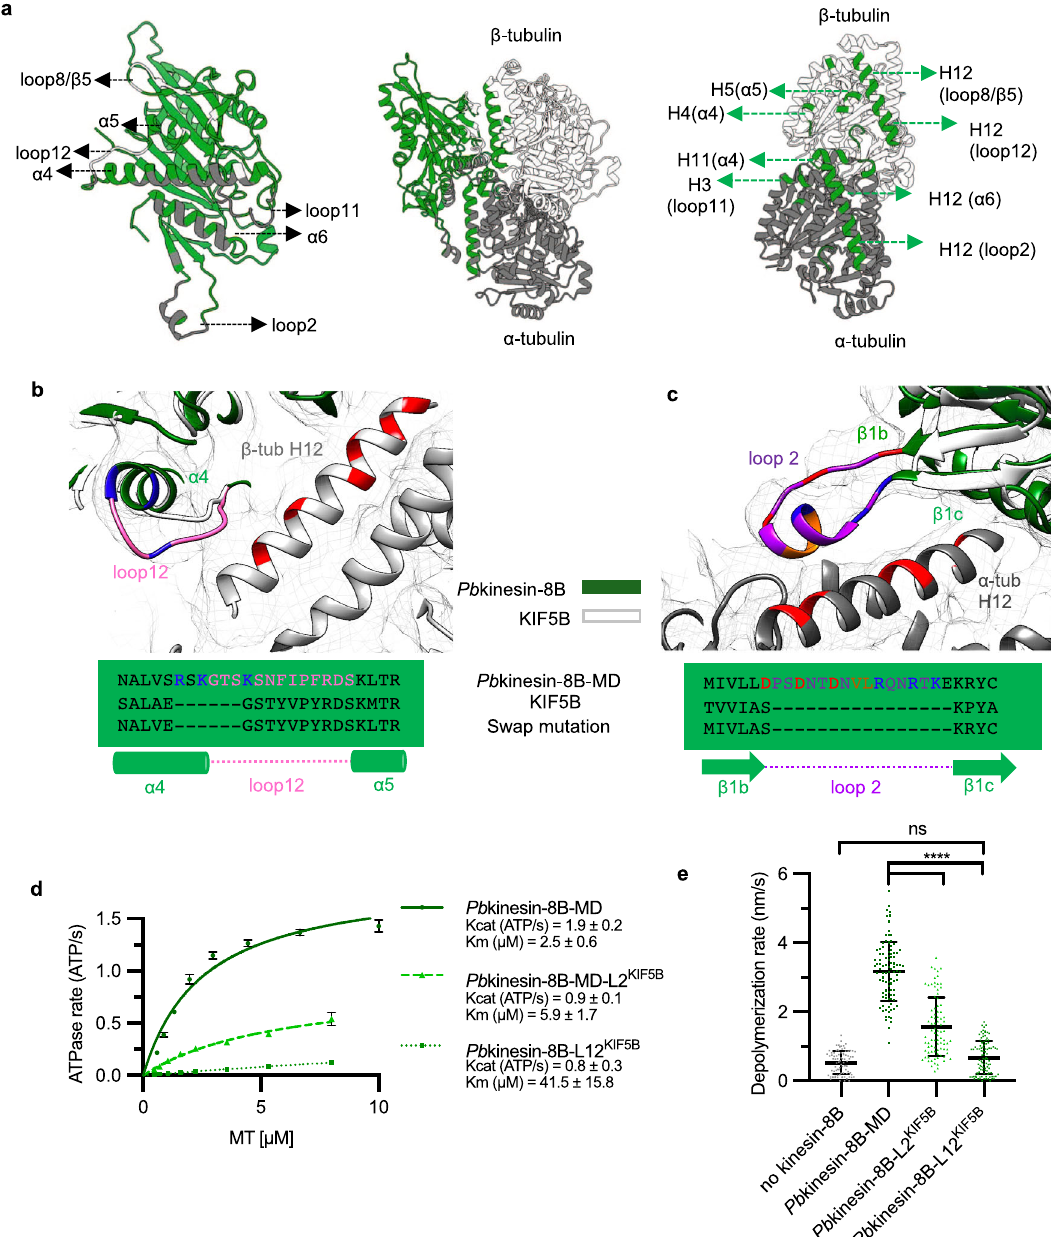
Fig. 4 | The MT-binding interface of Pb kinesin-8B-MD and contributions to motor function. a Middle, ribbon depiction of the Pb kinesin-8B-MD and tubulin dimerNNstatemodel,with Pb kinesin-8B-MDingreen, α -tubulinindarkgreyand β - tubulininlightgrey;left,zoomedviewofthe Pb kinesin-8B-MDMT-bindingsurface coloured according to contacts with α -tubulin (dark grey) and β -tubulin (light grey);right,MTfootprintof Pb kinesin-8B-MDon α -and β -tubulinindicatedindark green (tubulin residues <5Å distance from the bound motor). Labels indicate the speci fi c contacting secondary structure elements in tubulin dimer and Pb kinesin- 8B-MD(in bracket). b Structural alignment of the Pb kinesin-8B-MD model (green) and KIF5B motor domain model (PDB 6OJQ, white), focusing on the loop 12, with the Pb kinesin-8B-MD-NN cryo-EM density shown in mesh representation. A sequence alignment of this region, and the swap mutant, is depicted below. Pb Kinesin-8B-MD loop 12 is coloured pink with positively charged residues coloured blue. Negatively charged residues in the adjacent H12 of β -tubulin are coloured red; c Structural alignment of the Pb kinesin-8B-MD model (green) and KIF5B motor domain model (PDB 6OJQ, white), focusing on loop 2, with the